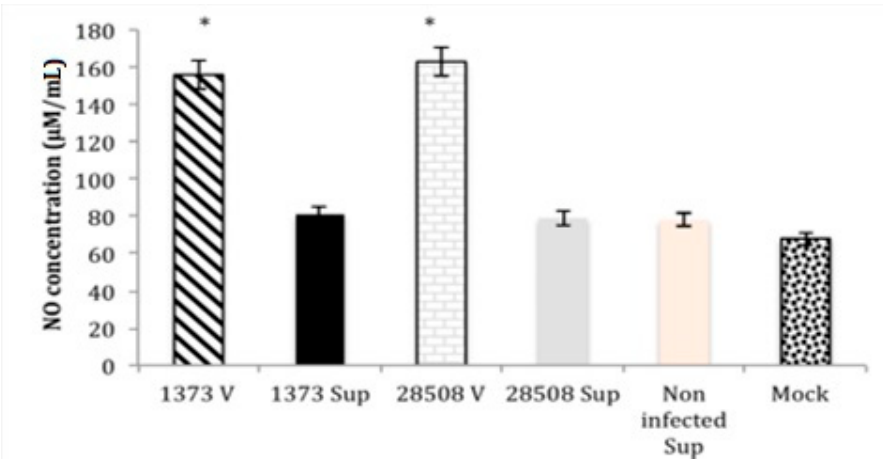
Figure 4. Comparison between the direct effect of BVDV strains and the corresponding infected-MDM supernatants (the indirect effect) on macrophage nitric acid production 24 h post-treatment. Sup: supernatant (indirect effect), V: virus (direct effect). *: p < 0.05 (>95% confidence).